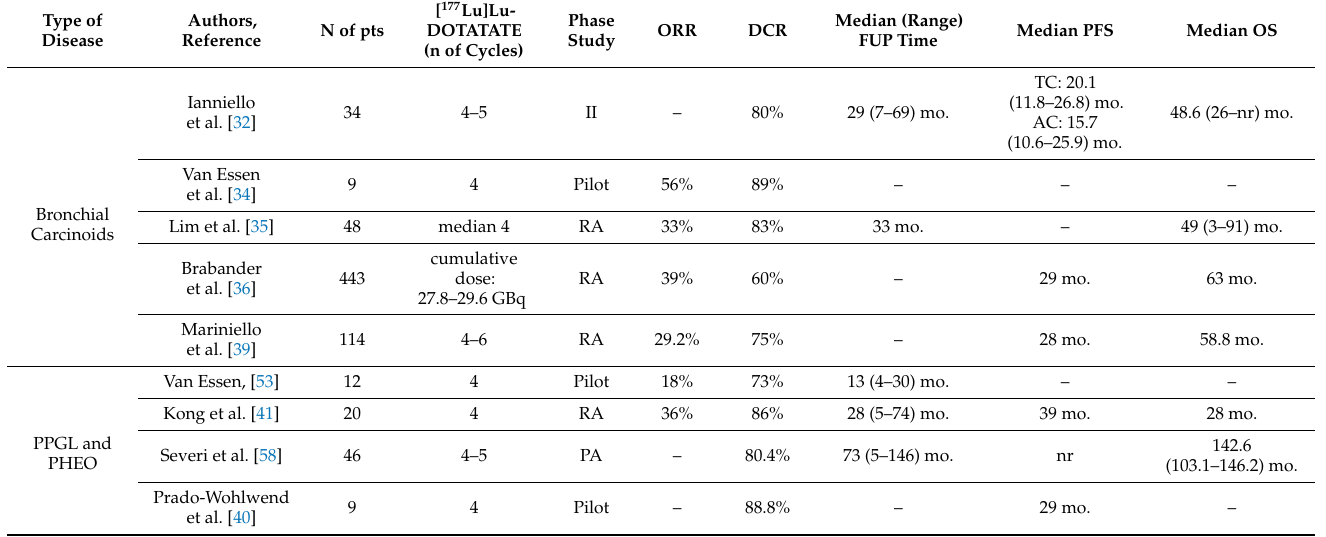
Table 1. Response rate and outcomes in the most relevant papers on neuroendocrine “orphan” neoplasms treated with [ 177 Lu]Lu-